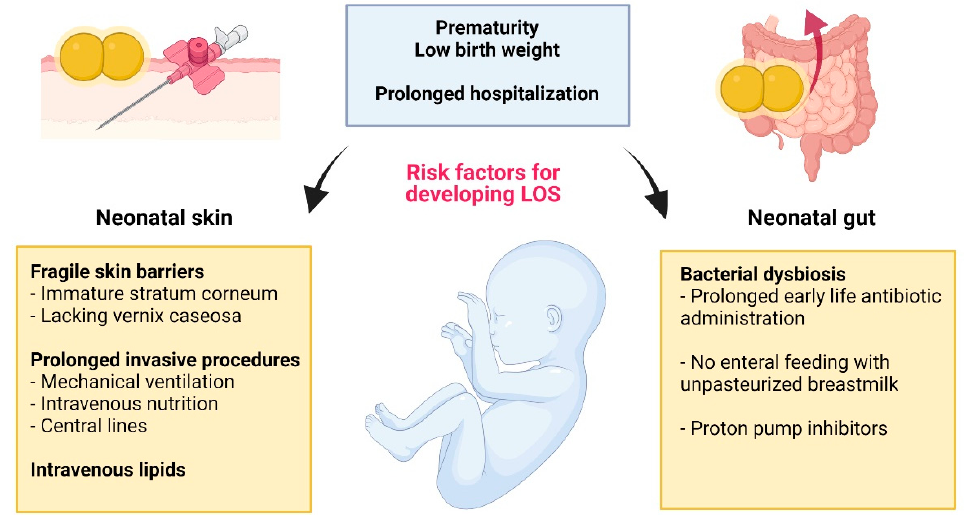
Figure 2. Risk factors associated with skin-derived and gut-derived S. epidermidis late-onset sepsis (LOS) in the preterm neonate. Created with BioRender.com.